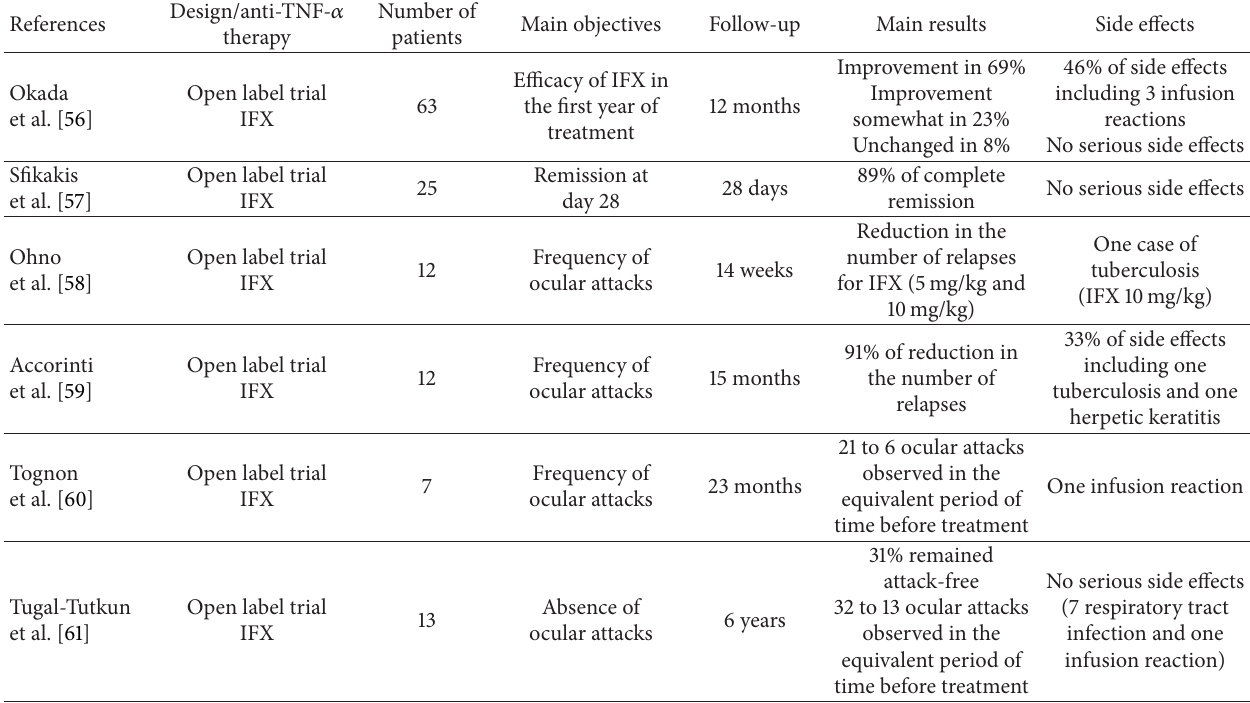
Table 4: Open label and randomized controlled trials performed in Behcet’s uveitis.